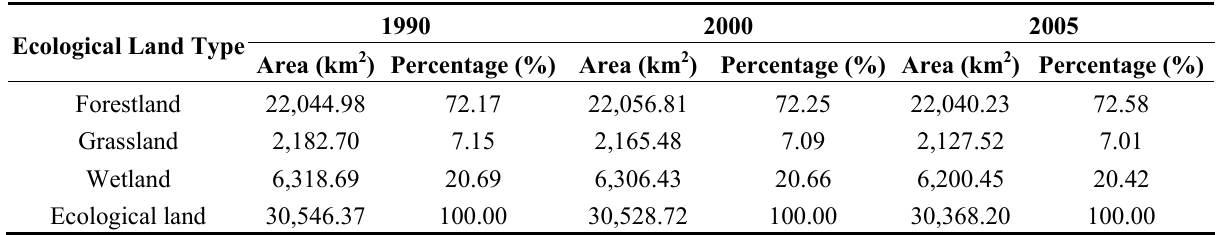
Table 1. Ecological land changes in the Poyang Lake Eco-economic Zone from 1990 to 2005.